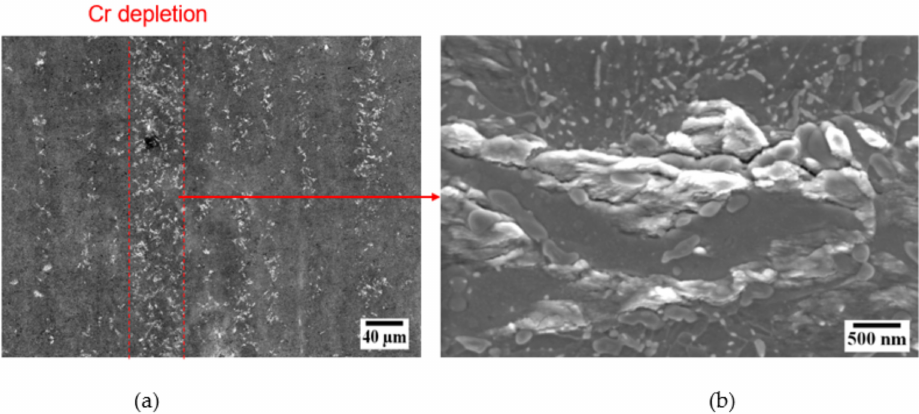
Figure 7. ( a ) Localized fatigue damage in Cr depleted zones, ( b ) persistent slip markings (PSM) at the surface of the 50CrMo4—37HRC steel, tested at 95 Hz, σ a = 480